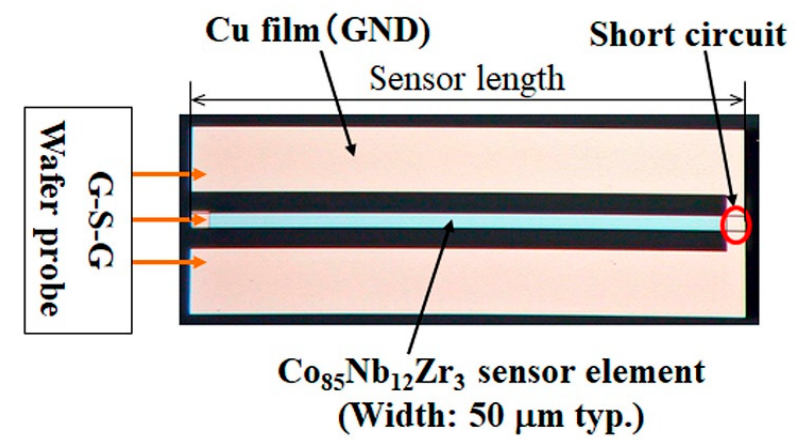
Figure 9. Photograph of sensor element, used for the first experiment.